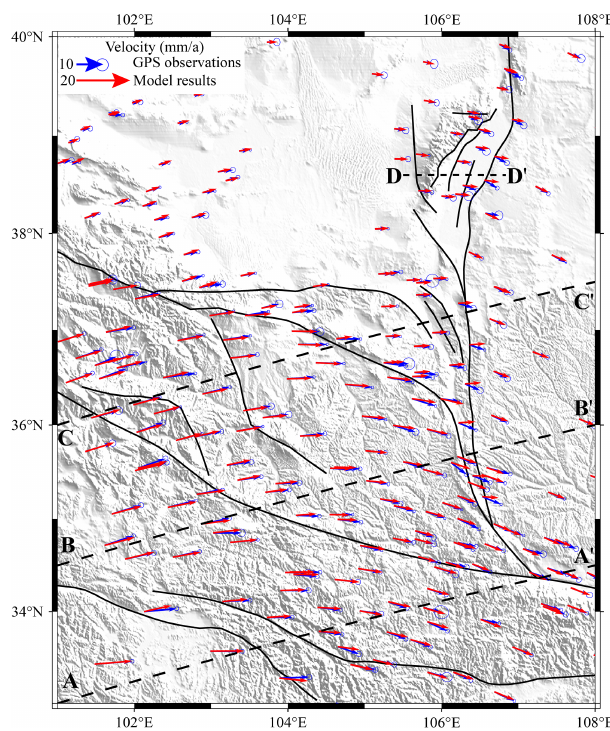
Figure 11. Comparison of the modeled horizontal velocities and GPS velocities. The red arrows represent the modeled results, and the blue arrows are the GPS measurements (Wang and Shen, 2020). The dashed line is the location of the profile in Figs. 12 and 14.